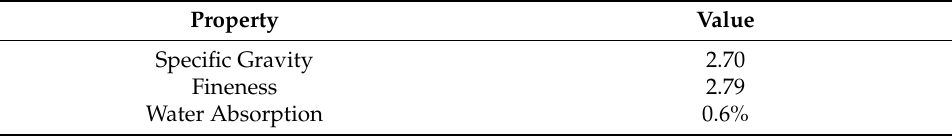
Table 4. Physical properties of fine